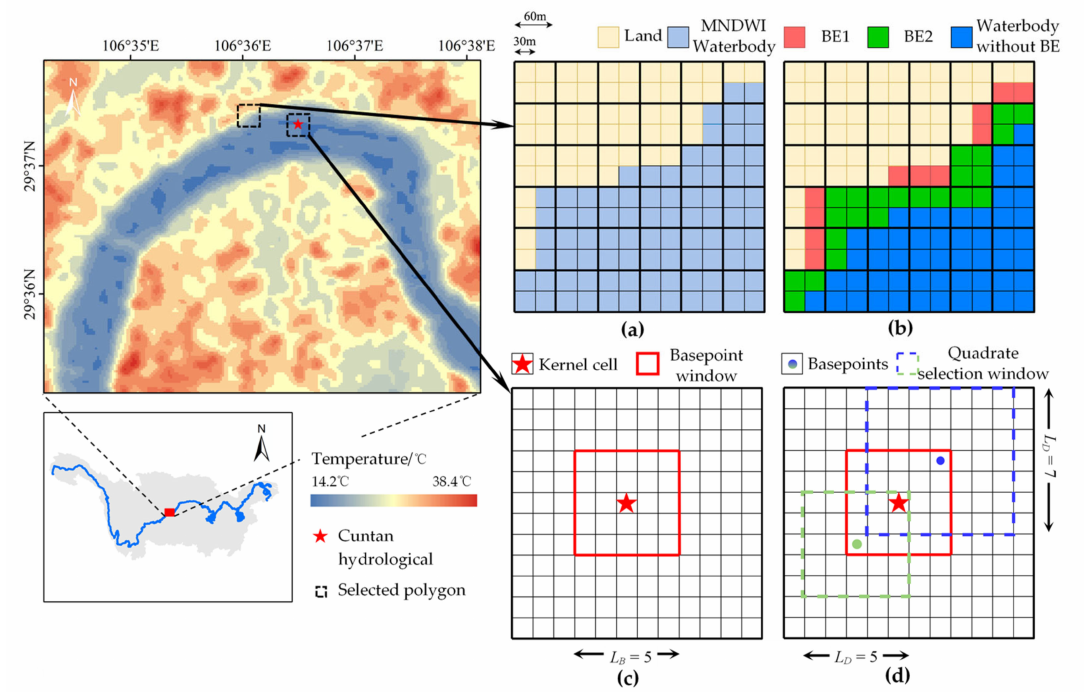
Figure 3. Illustrations of two boundary effects: ( a ) Modified Normalised Difference Water Index (MNDWI) waterbody ( b ) Boundary Effect 1 (BE1) and Boundary Effect 2 (BE2) and the quadrate selection method: ( c ) basepoint window and ( d ) quadrate selection window based on Landsat 5 TM-derived river temperature distribution of study area B on 27 October